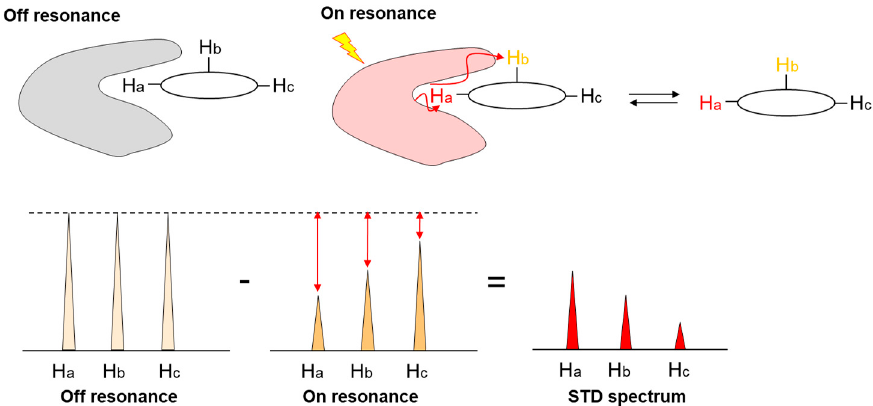
Figure 3. Mechanism of Saturation transfer difference nuclear magnetic resonance (STD-NMR). “Off resonance” experiment gives a reference spectrum. Under “on resonance” conditions, the saturation is transferred from protein to ligand by spin diffusion through intermolecular nuclear Overhauser effects (NOEs). The closer the protons are to the protein, the stronger the STD signals that are observed.